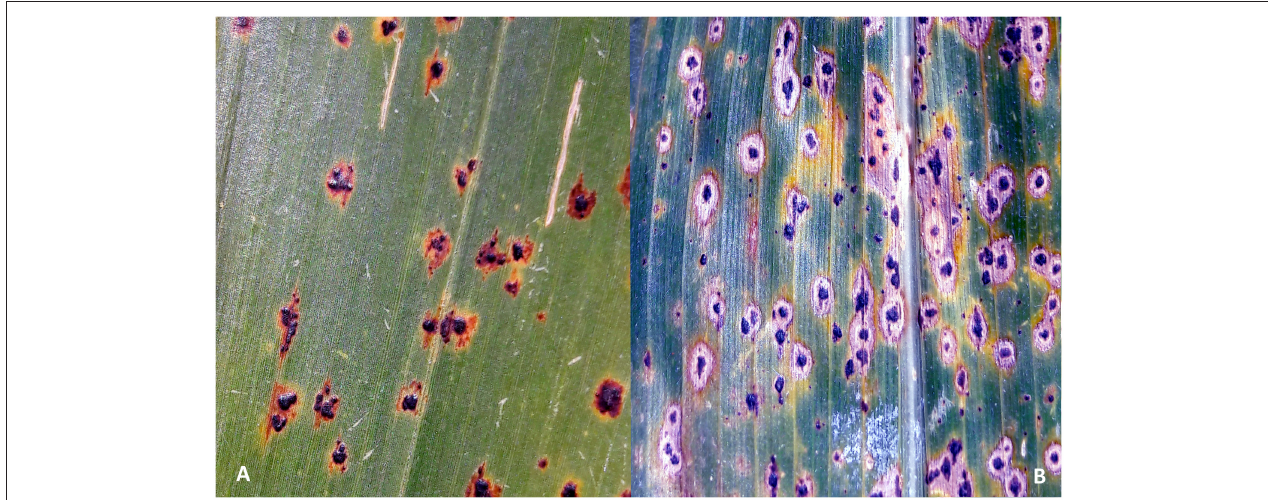
FIGURE 1 | Symptoms of tar spot complex (TSC) on maize plants: (A) stromata of Phyllachora maydis appears on leaves initially; (B) chlorotic and necrotic spots caused by Monographella maydis surround the stromata of P. maydis 2 weeks later causing the so called “fish-eye” ∼